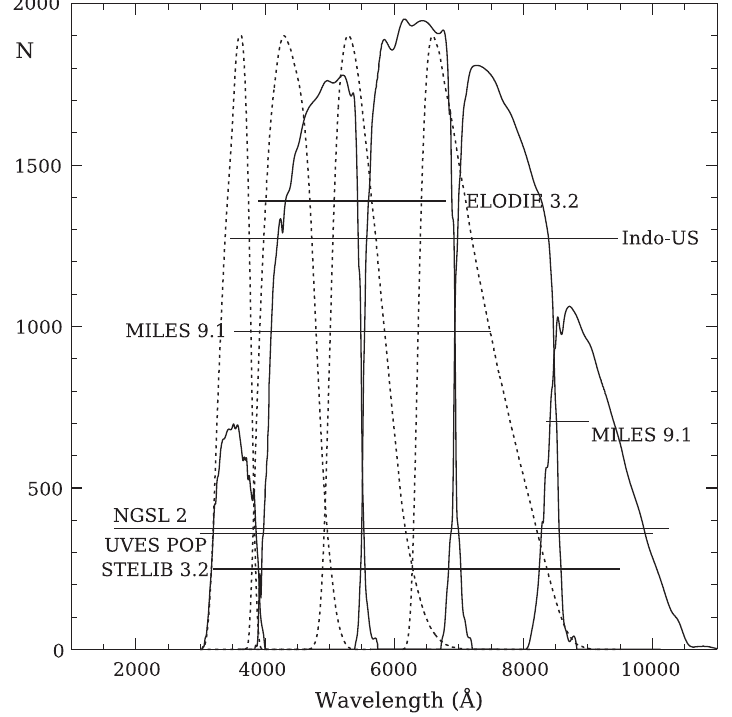
Fig. 7. The horizontal lines represent modern empirical spectrophotometric at- lases: number of stars vs. spectral coverage. The SDSS (solid) and WBV R (dashed) response curves are also